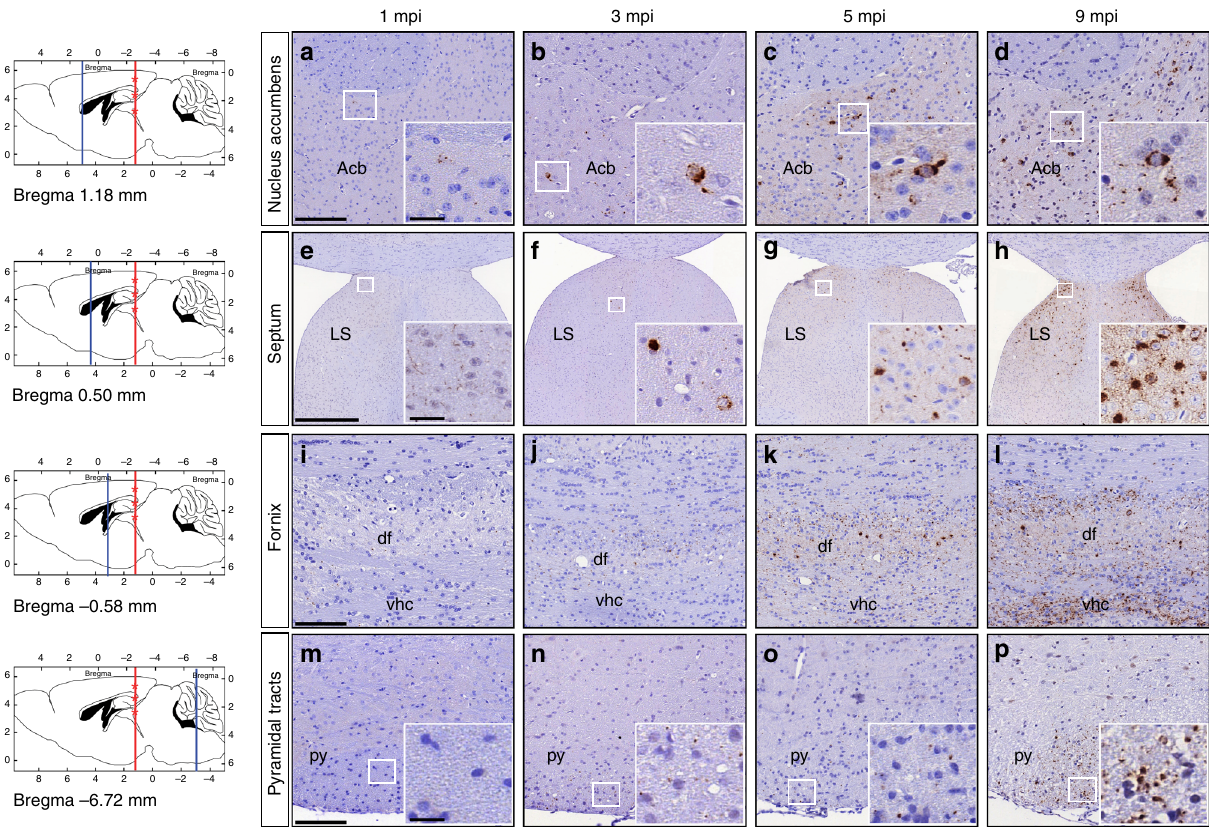
Fig. 5 TDP-43 pathology spreading to rostral deep brain nuclei and white matter tracts. Representative photomicrographs of p409-410 IHC staining in rostral deep brain nuclei distal from the injection sites and white matter tracts over time in CamKIIa-hTDP-43 NLSm mice at 1 mpi ( n = 3), 3 mpi ( n = 2), 5 mpi ( n = 3), and 9 mpi ( n = 3). The panels in the far left column illustrate sagittal views of the corresponding coronal planes (blue line) and three sites of the injection into cortex, hippocampus, and thalamus (red asterisks). p409-410 IHC staining in nucleus accumbens (Acb) ( a – d , bregma 1.18 mm), septum ( e – h , lateral septum (LS), bregma 0.50 mm), and white matter tracts in fornix ( i – l , dorsal fi mbria (df) and ventral hippocampal commissure (vhc), bregma − 0.58 mm) and pyramidal fi ber tracts (Py) ( m – p , Bregma − 6.72 mm). Insets are higher magni fi cations of the white boxes in a – h and m – p . Scale bar = 100